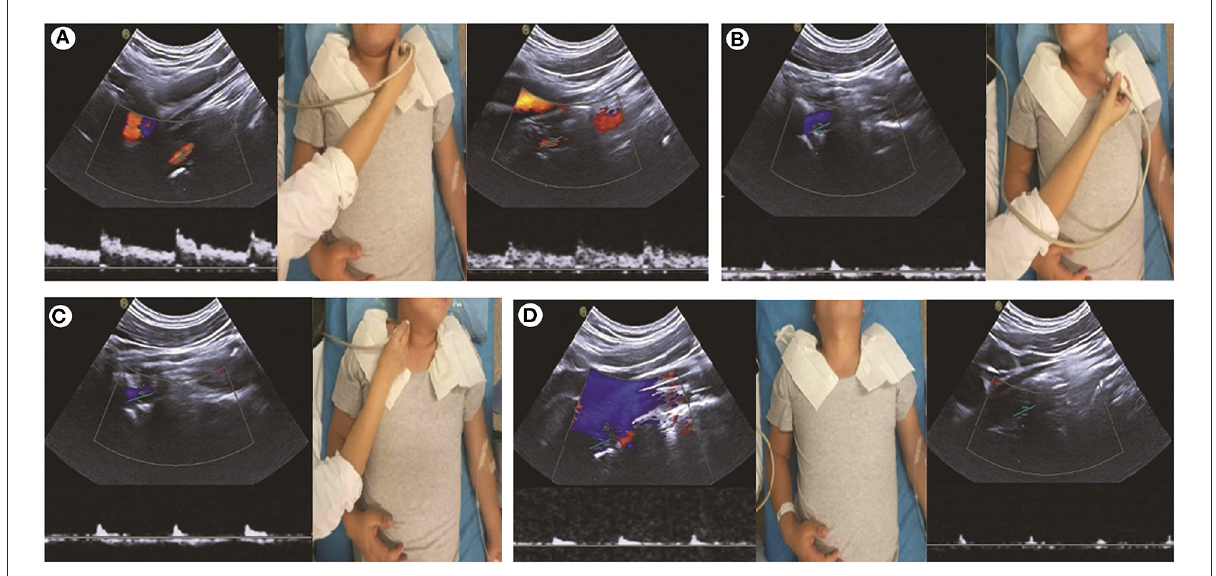
FIGURE1 Carotid artery ultrasound shows abnormalities during neck rotation. (A) The velocity of blood flow and spectrum of the bilateral vertebral artery (VA) is normal with the patient’s neck in the neutral position. (B, C) Low bloodstream and high resistance during the head rotation to the contralateral side, indicating that the distal part of the VA is occluded. (D) Bilateral VA is occluded when the head is tilted backward.